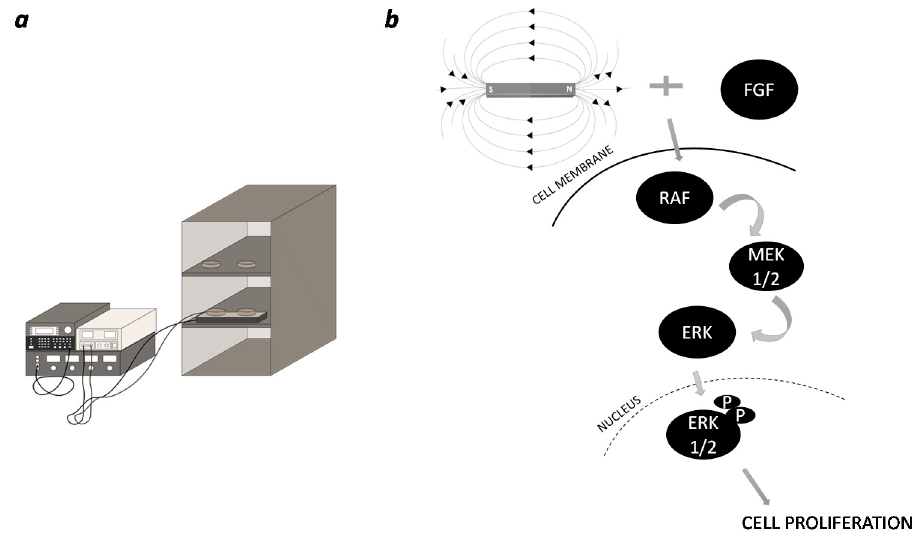
Figure 6. ( a ) Illustration of the magnetic device and of the incubator equipped with electromagnet. ( b ) Schematics illustrating the MAPK signalling pathway triggered by exposure to magnetic field.